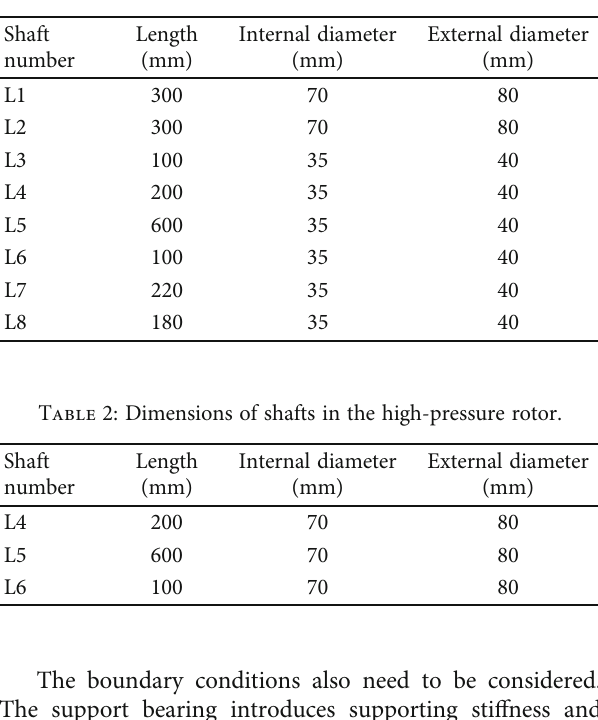
(b) Finite element model Figure 1: Schematic of engine system Table 1: Dimensions of shafts in the low-pressure rotor.